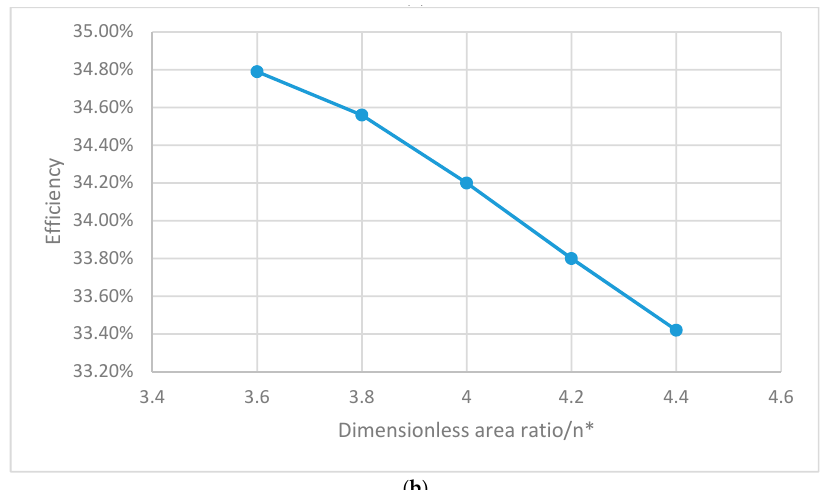
Figure 12. Relationships of the output power, efficiency and the area ratio of the pistons. ( a ) Output power trend curve influenced by the area ratio of the pistons; ( b ) Efficiency trend curve influenced by the area ratio of the pistons.